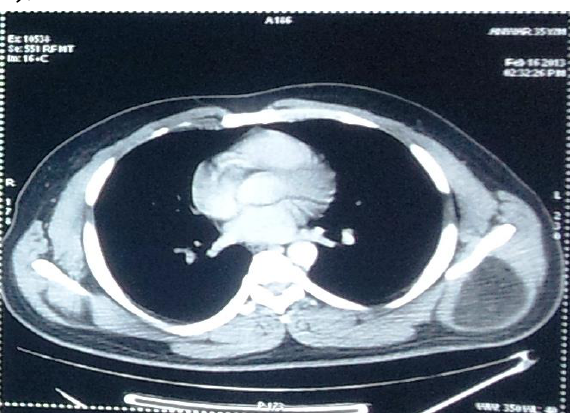
Figure 1. CECT shows a well circumscribed, minimally enhancing, hypodense lesion measuring 8x7.5cm with attenuation corresponding to fat density in left periscapular area.